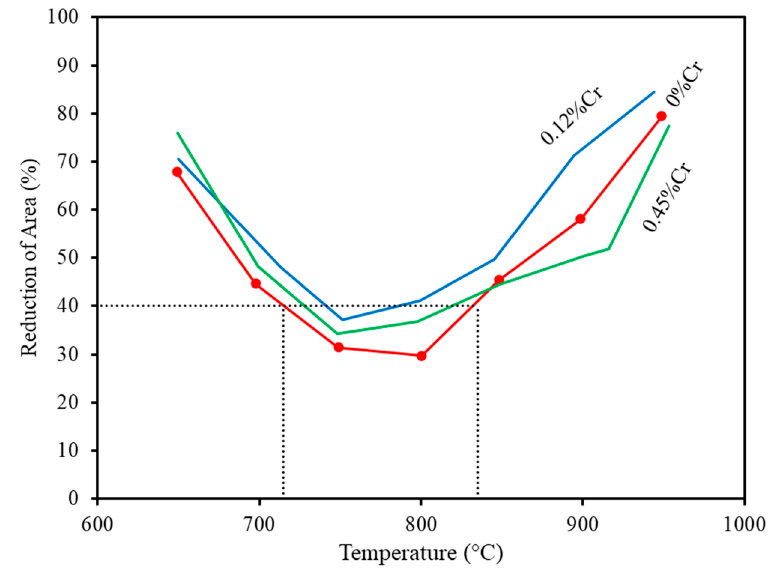
Figure 1. The hot ductility curves of an HSLA steel with base composition 0.14% C, 1.45% Mn, 0.029% Nb, and 0.002% N for three levels of Cr, 0, 0.12, and 0.45% [10], with permission from publisher Spring Nature, 2023.